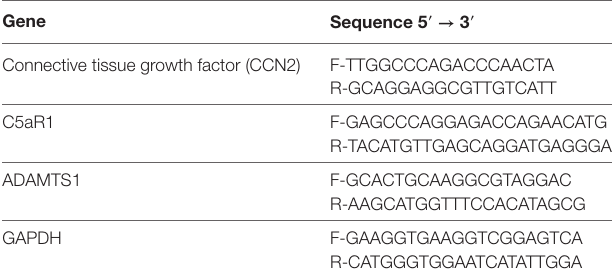
Table 1 | List of primers used for qPCR. gene sequence 5 ′ → 3 ′ Connective tissue growth factor